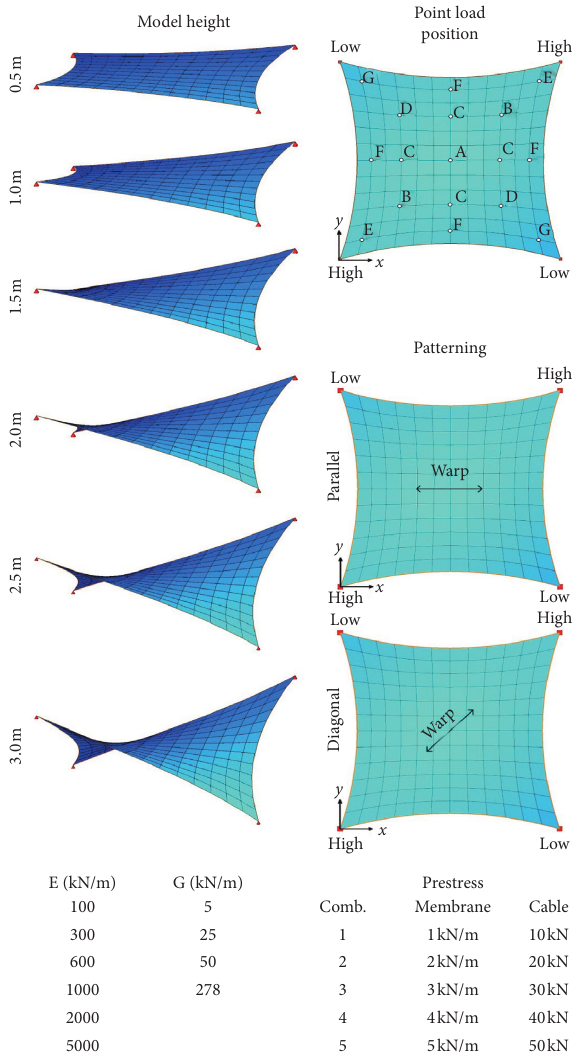
Figure 2: Values of the variable parameters.